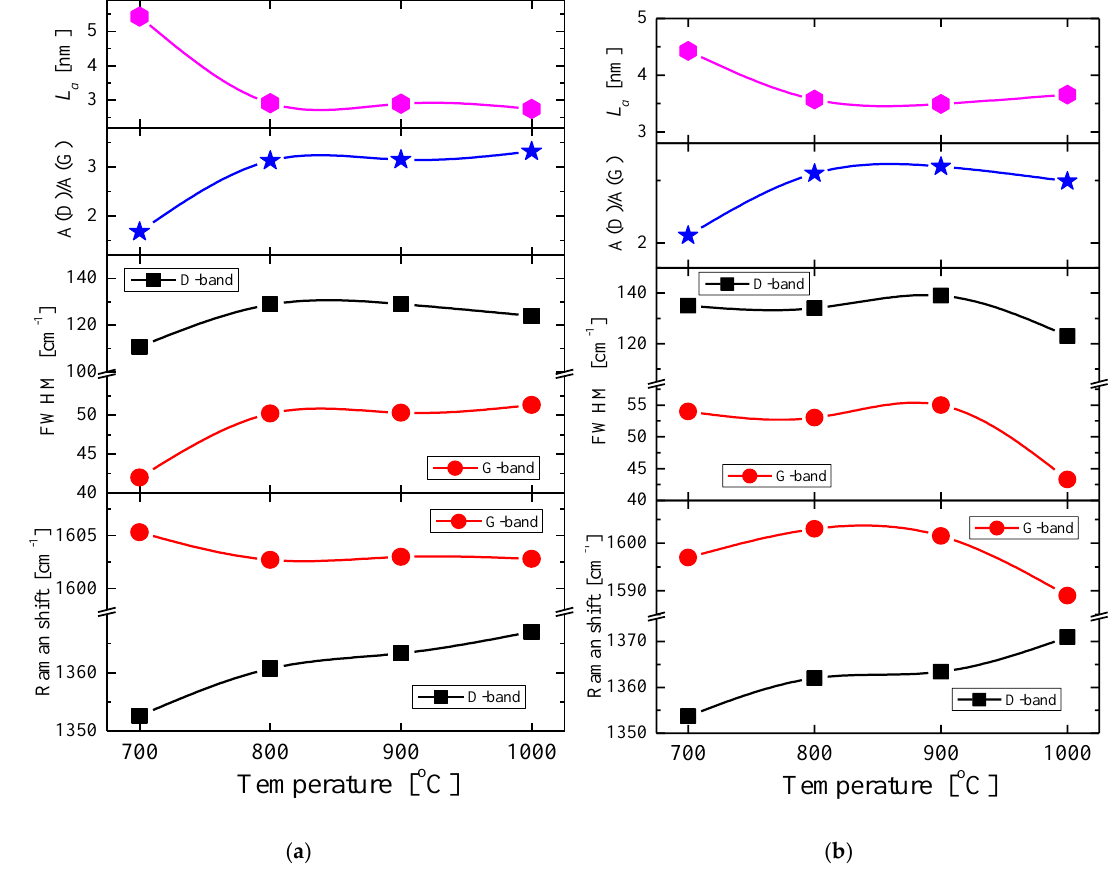
Figure 8. Variation of the Raman spectra fit parameters of ( a ) C1-TS and ( b ) C2-Fe vs. temperature. From bottom to top: D and G bands’ frequencies, D and G bands’ full widths, area ratios, and crystallite size. The lines are drawn as guides to the eye.